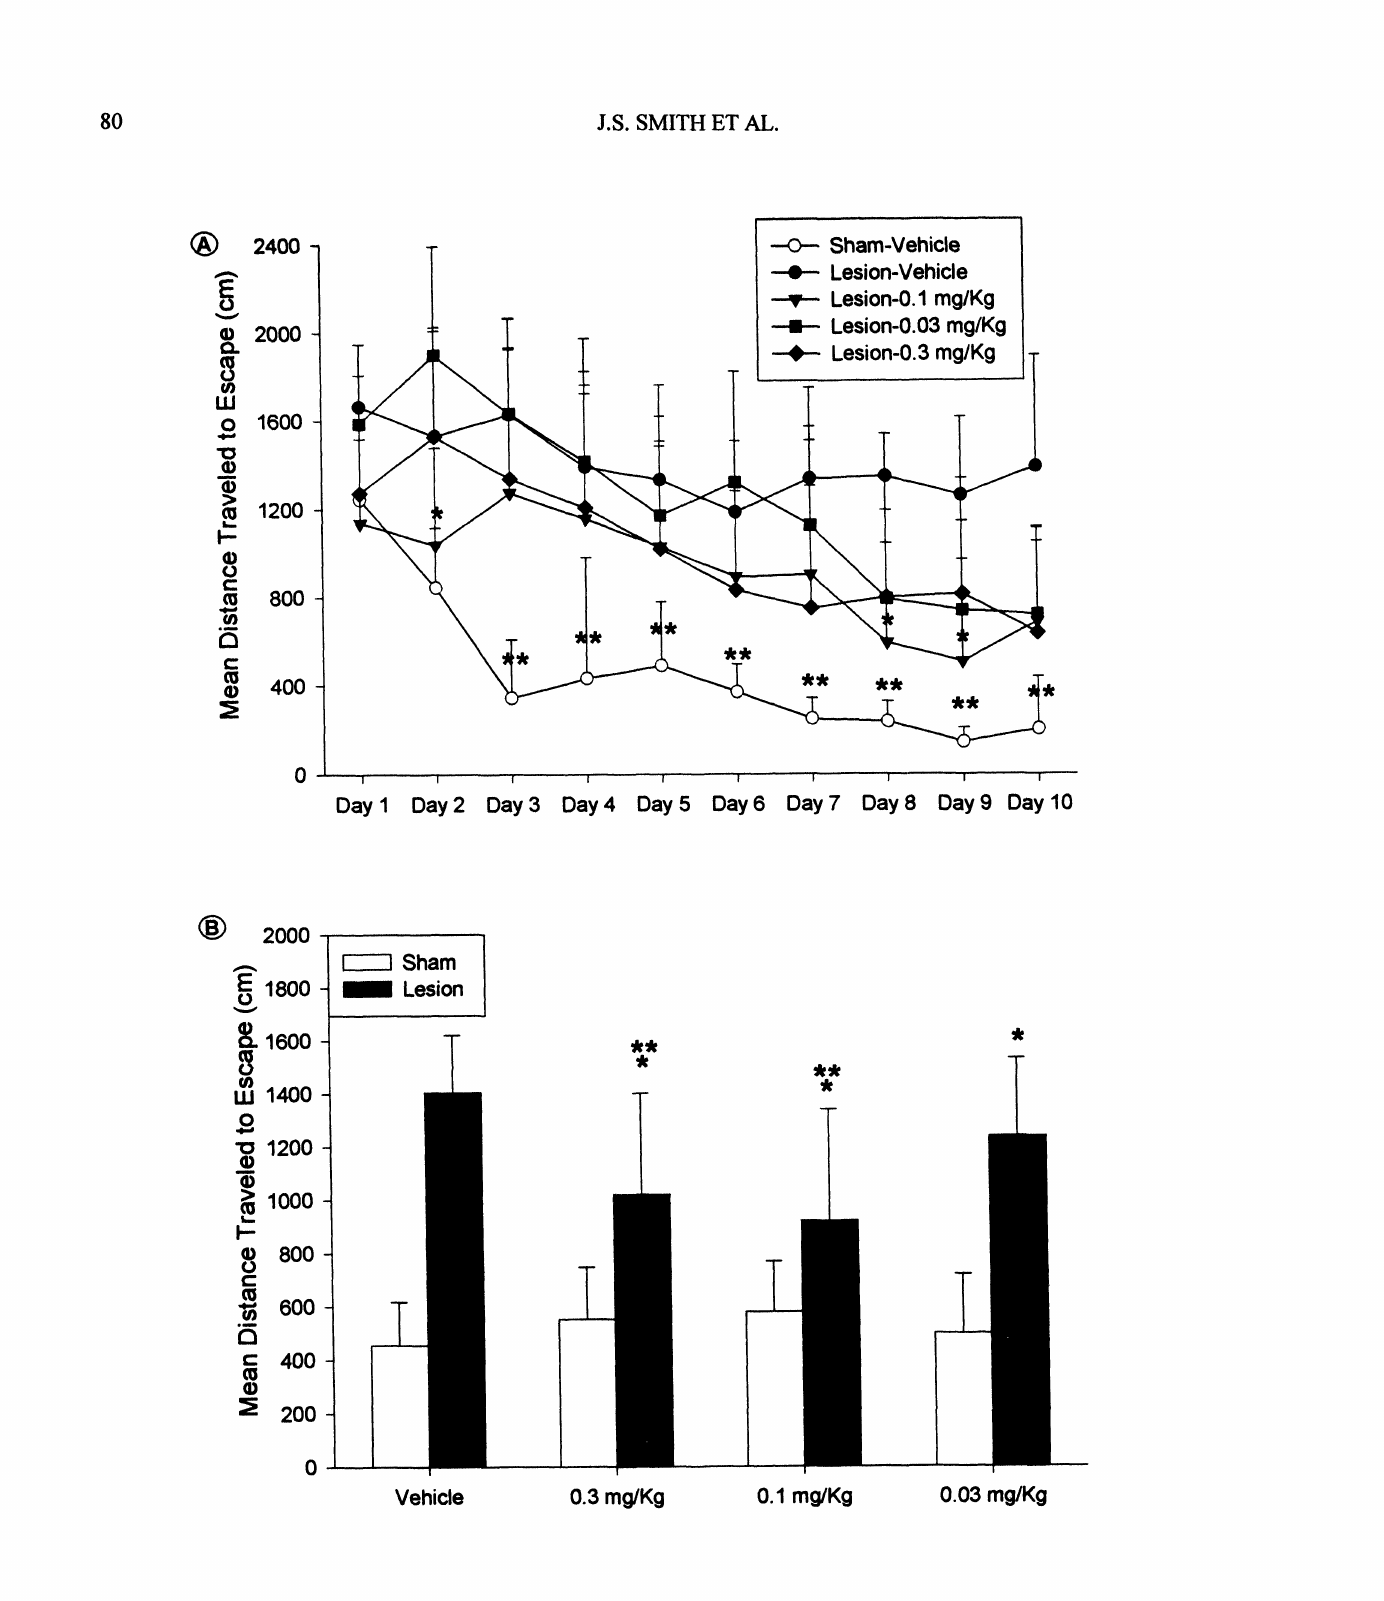
Fig. 3" (a) Measures of swim distance in the water tank before f’mding the escape platform shows that on the second, eighth, and ninth day of training, rats given 0.1 mg/kg of gacyclidin prformd bttr than the other treatment groups (*=p<0.05). Regardless of dose, intact rats performed significantly better than any gacyclidine-trcated group (**=p<0.05). (b) When collapsed across days, the data revealed that injured rats treated with the two higher doses of gacyclidine performed better than those treated with 0.03 mg/kg of gacyclidine or with the vehicle (**=p<0.05). All injured rats receiving gacyclidine, regardless of dose, performed better than their untreated counterparts (*=p<0.05). (Error bars represent standard